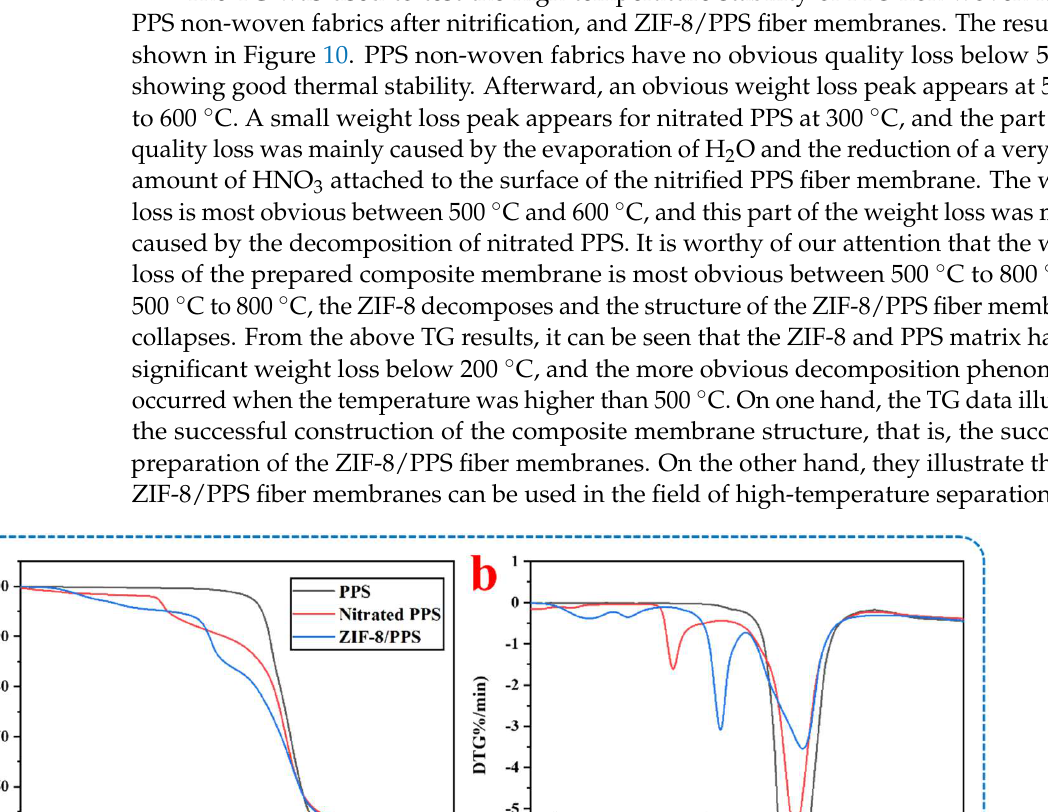
Figure 9. High-temperature resistance experiment diagram of PPS matrix.